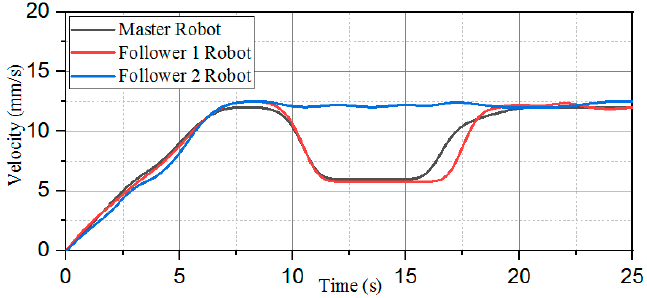
Figure 27. Relative localization offset with an interchange queue ( ∆ d is the relative distance between two robots).